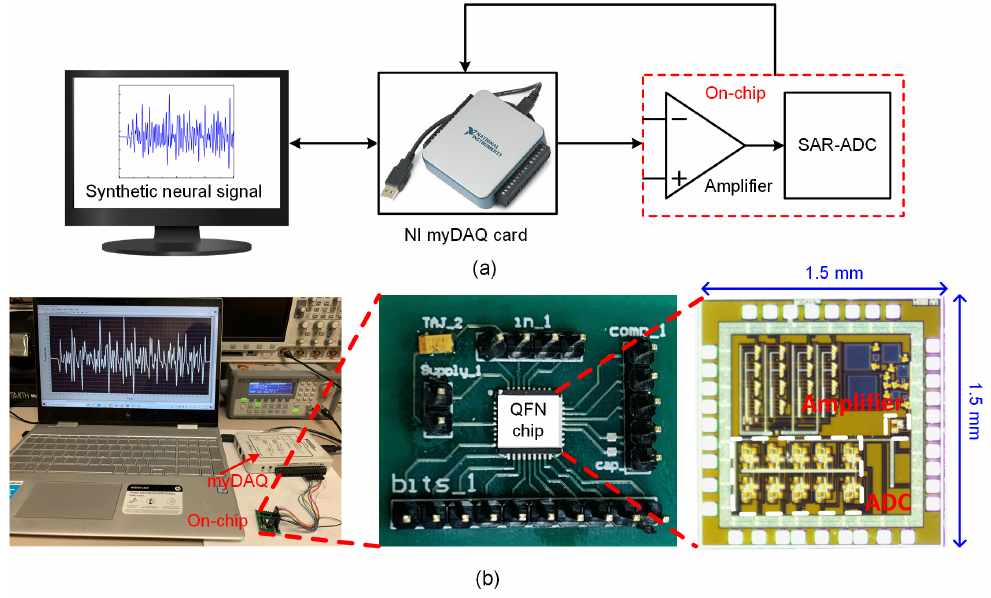
Figure 6. ( a ) Block diagram of the experimental test setup of the system, ( b ) actual test-setup with the quad-flat no-lead (QFN) chip and chip microphotograph.